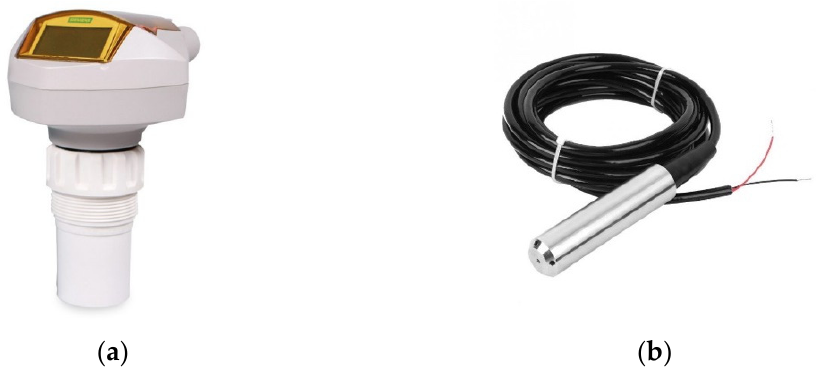
Figure 3. Level sensors: ( a ) Siemens ultrasonic level sensor; ( b ) TL ‐ 136 liquid level transmitter.